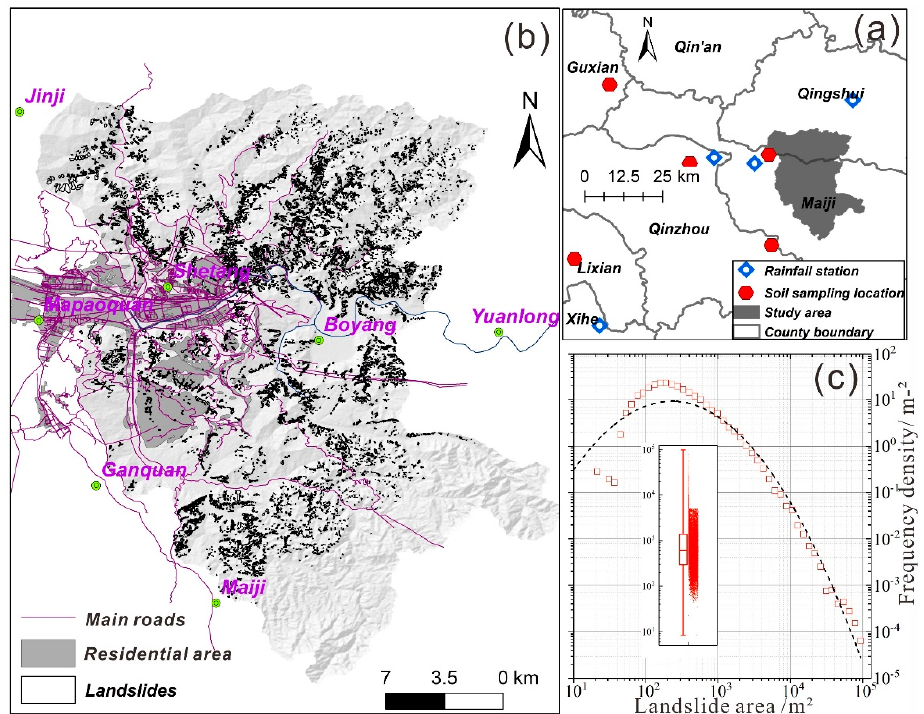
Figure 4. The distribution of residential areas, main roads, and landslides caused by the 2013 rainfall event in the study area: ( a ) The locations of the national rainfall stations and soil samples used in this study. ( b ) The distribution of rainfall-induced landslides of the 2013 rainfall event; ( c ) Frequency density of the landslide size (area in m 2 ) distribution. The road and resident data were obtained from the OpenStreetMap database (https://master.apis.dev.openstreetmap.org/export#map=11/35.2510/103.4308).